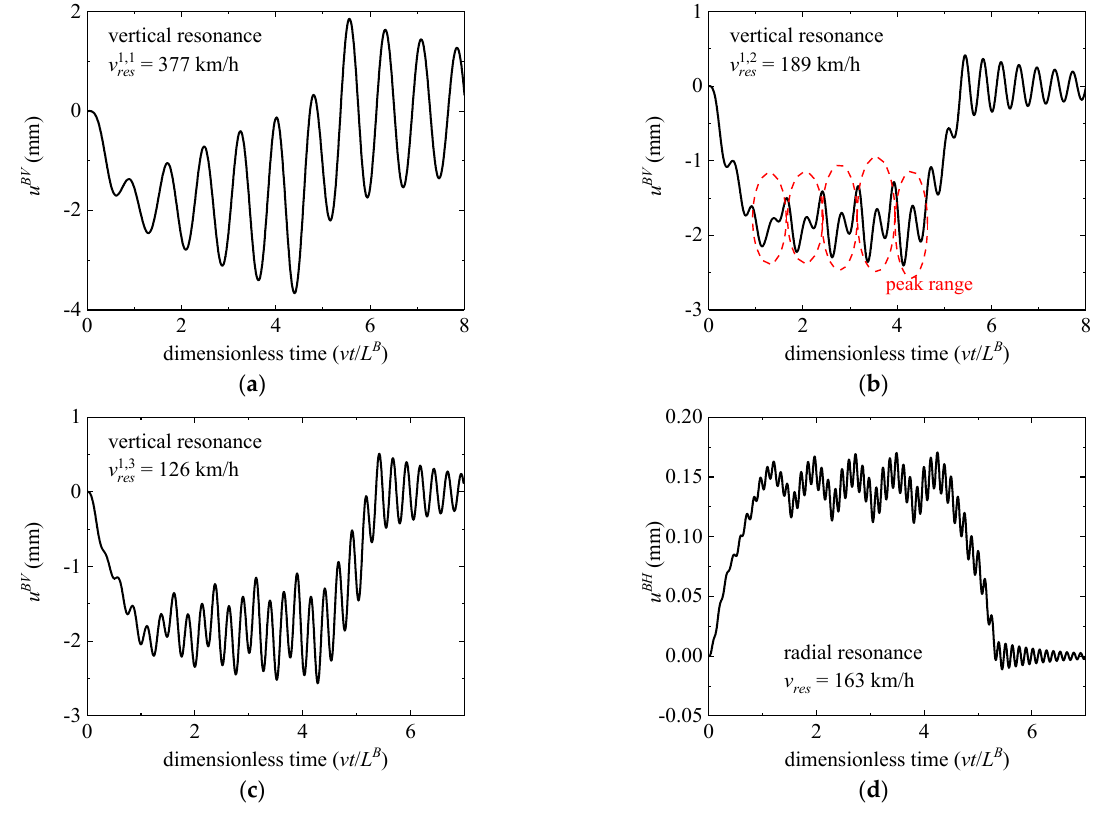
Figure 9. Time-history response of bridge spanning 25 m under resonant velocity: ( a ) 1st vertical resonance of 1st mode; ( b ) 2nd vertical resonance of 1st mode; ( c ) 3rd vertical resonance of 1st mode; ( d ) Radial resonance.